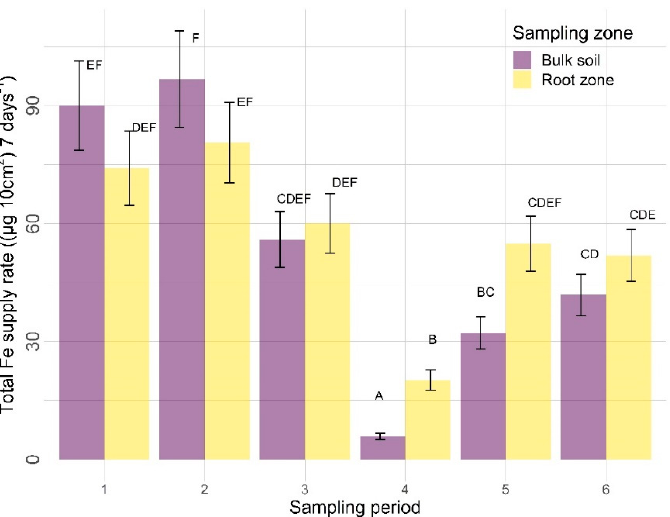
Figure 12. Fe supply rates as a function of sampling zone and time. Different letters indicate significance at p < 0.05 using the post hoc Tukey HSD test.